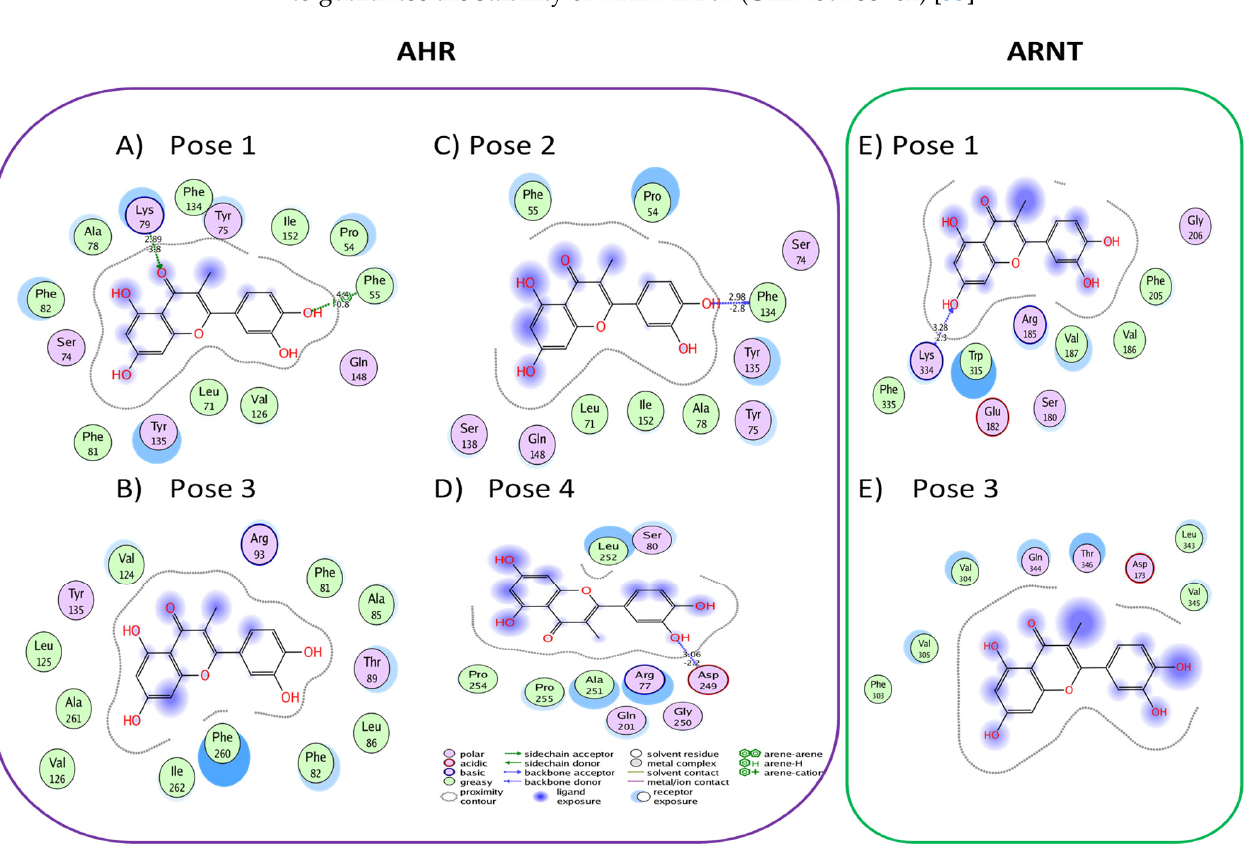
Figure 8. Interaction network between monomeric proteins AHR, ARNT and the studied compound 3 .